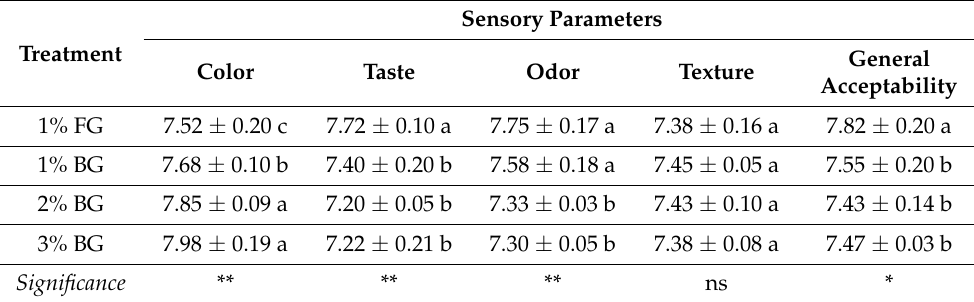
Table 2. The overall effect of garlic treatment on sensory characteristics of heat-treated sucuk (mean ±